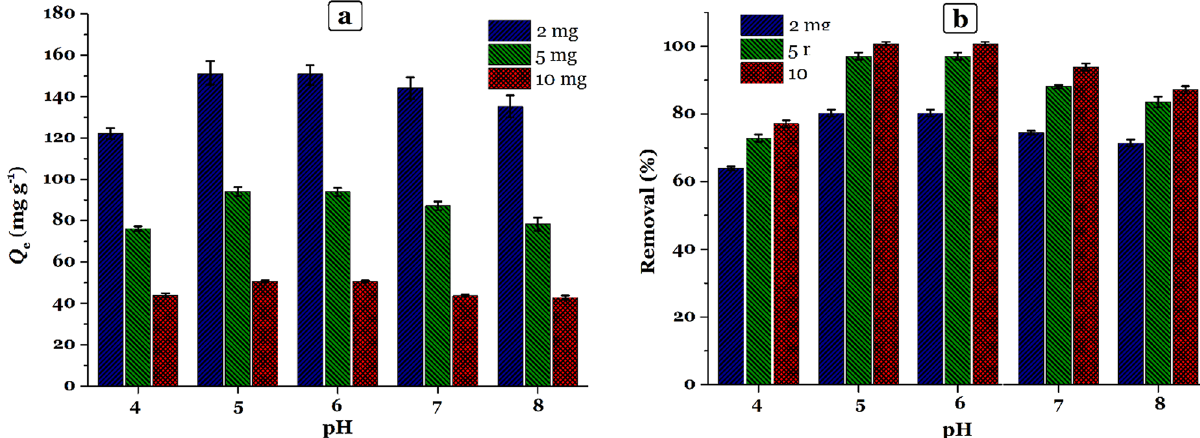
Figure 5. Effect of pH on the removal efficiency of Hg(II) by TSF-KCC-1